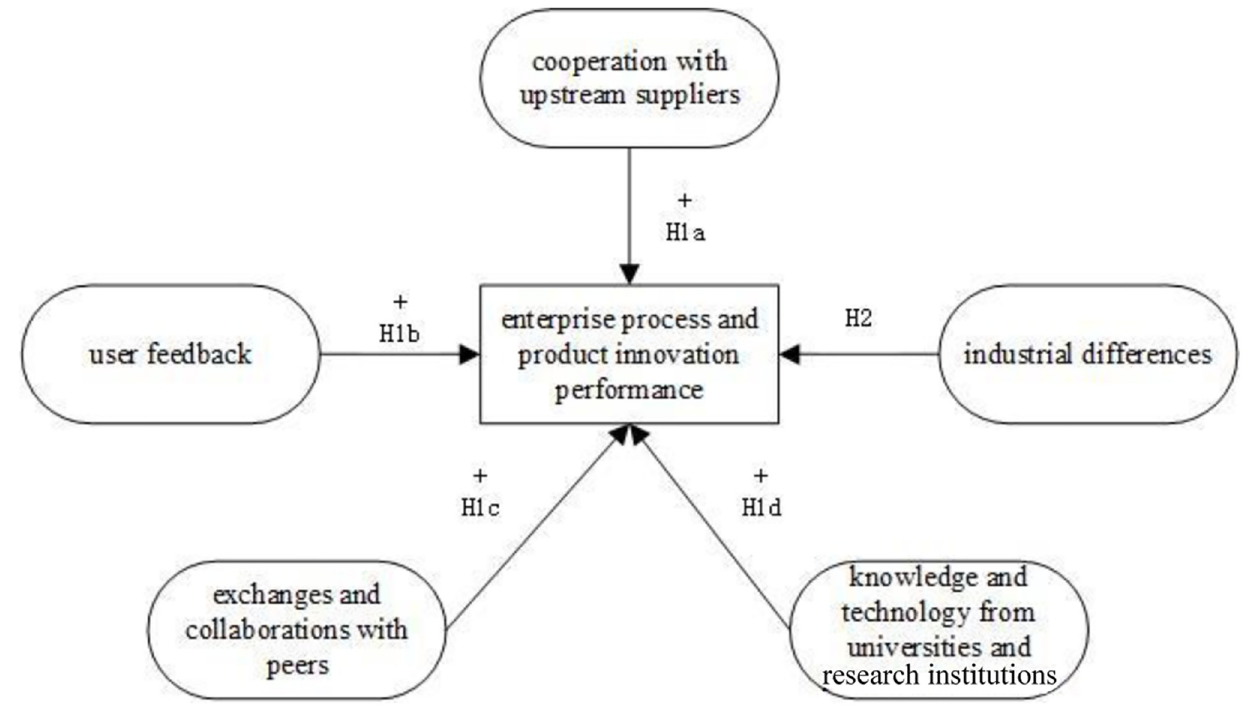
Fig 1. The relationship and analysis framework of theoretical